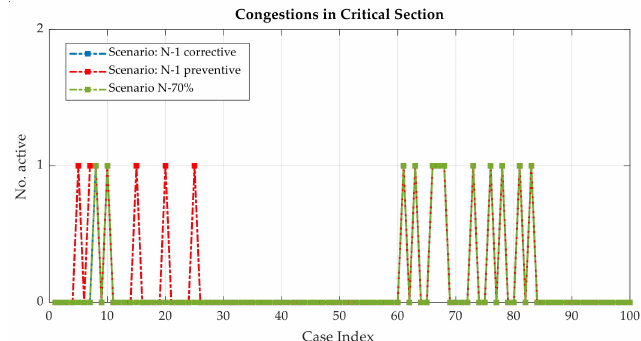
Figure 13. Congestions identified by critical section